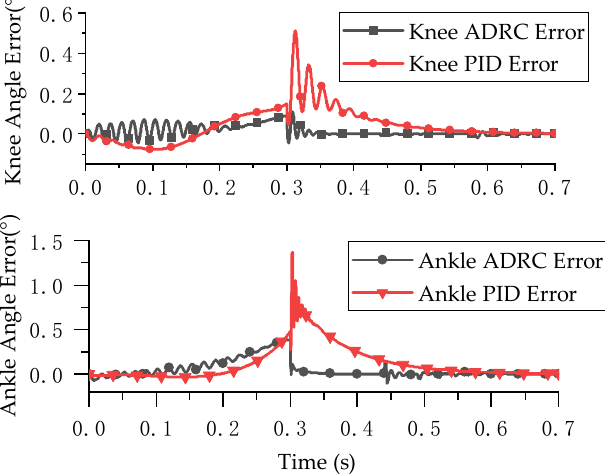
Figure 8. Joint angle tracking error.